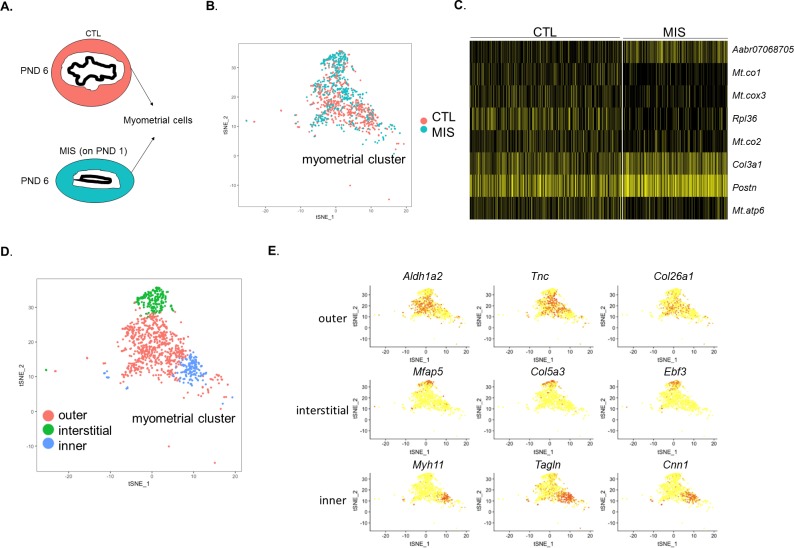
The myometrium cluster can be sub-divided into three different cell types whose gene signatures are only weakly affected by MIS treatment.Rat pups were injected with empty vector control (CTL) or AAV9-MIS (MIS) on PND 1 and analyzed by scRNAseq at PND 6 (A–E). (A) Representative schema of the myometrial layer composition in control (orange) and MIS-treated (blue) uteri. (B) t-SNE plot of the myometrial cluster with cells labeled according to treatment. Note that both the CTL and the MIS-treated cells are numerically and spatially similarly represented in the t-SNE plot. (C) Heatmap of differentially expressed genes in CTL and MIS-treated myometrium (Figure 3—source data 2). (D) Sub-clustering of the myometrium cluster revealed three distinct myometrial sub-populations in the developing PND 6 rat uteri. (E) Specific markers for the three cell subtypes (outer, interstitial (microfibril enriched), and inner) of the developing rat myometrium.